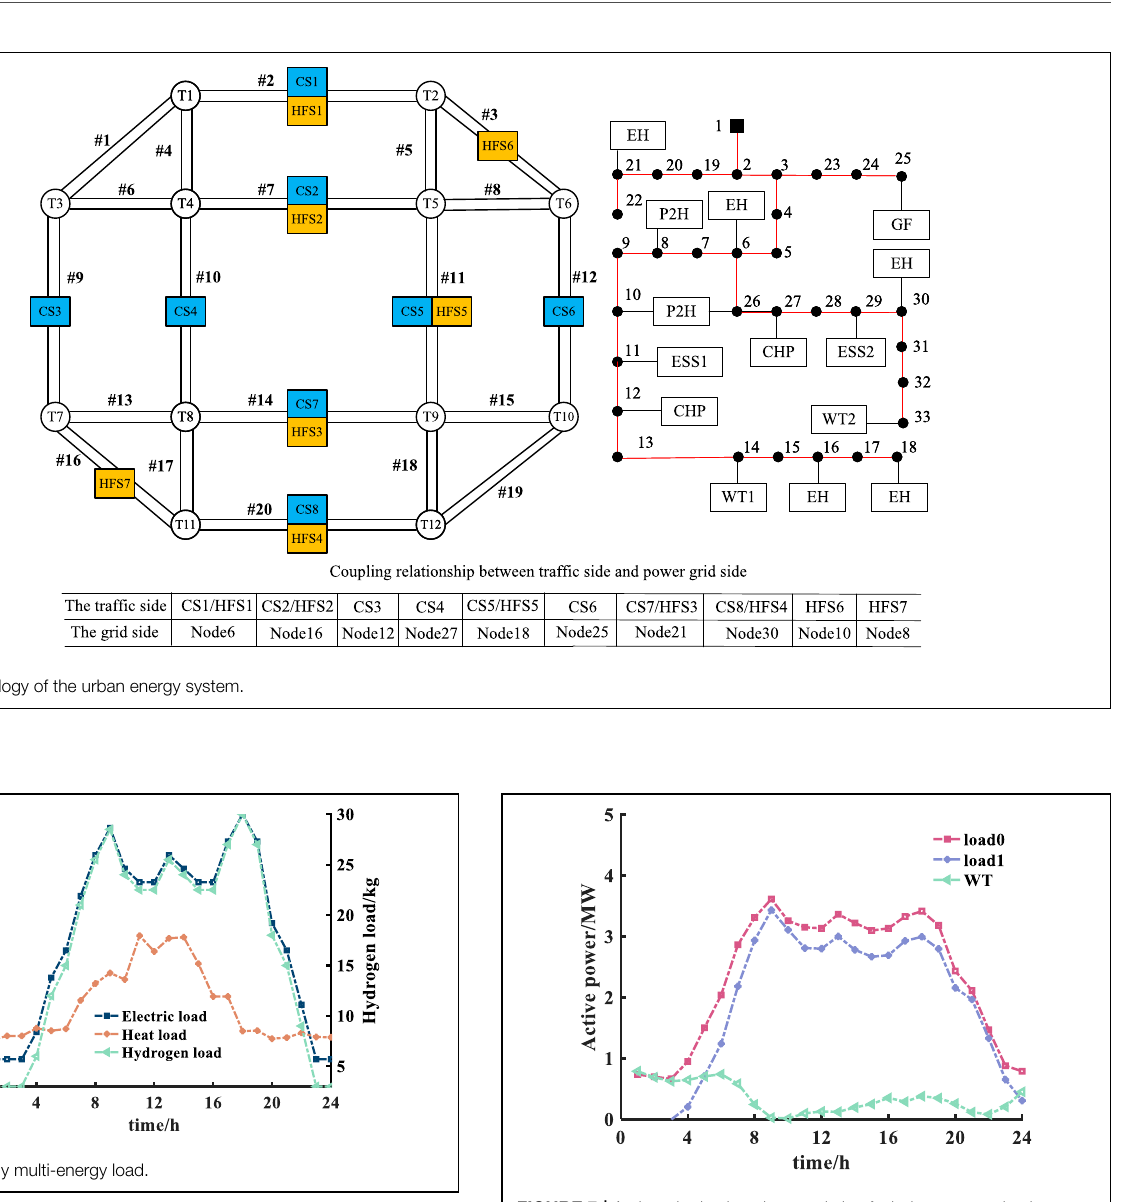
FIGURE 7 | Anti-peak-shaving characteristic of wind power